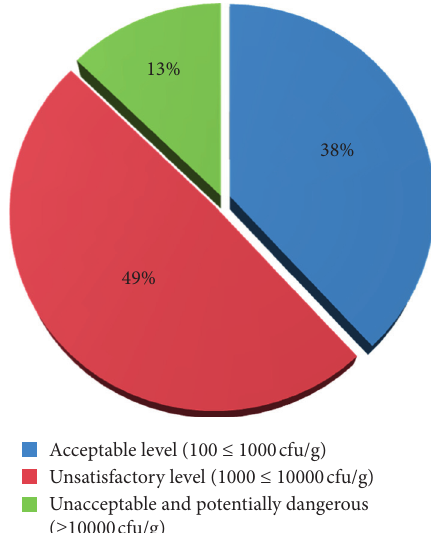
Figure 1: Microbial quality levels of butcher shops based on S. aureus count from raw beef in Bahir Dar city.